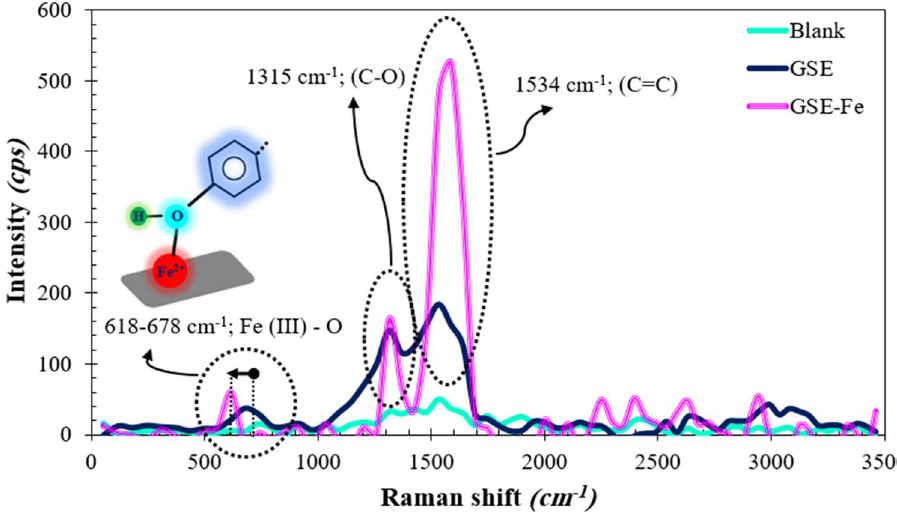
Figure 13. Raman spectroscopy of MS specimens dipped for 3 h in the acid solution with and without 300 ppm of GSE; the GSE-Fe complex is provided as a reference spectrum.